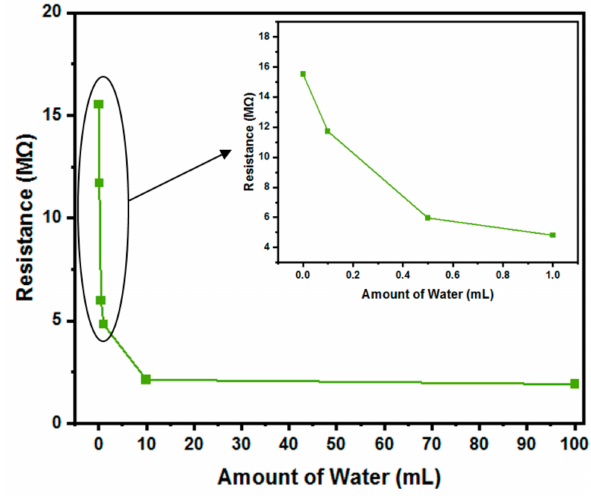
Figure 11. Graph of the resistance values of the humidity sensor against different amounts of